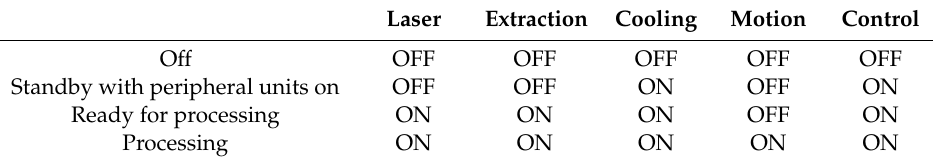
Table 3. Specific operating states investigated.